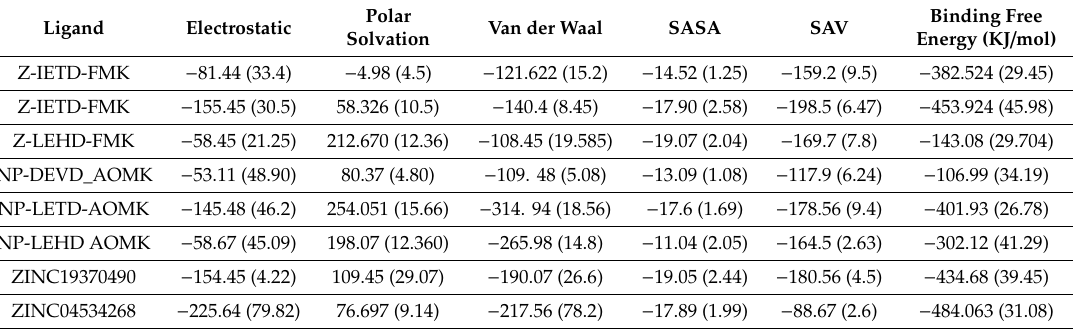
Table 5. MM-PBSA values (binding free energies) of di ff erent ligands with caspase 8. Each value represents the average value calculated from the last 100 snapshots. SASA, solvent accessible surface area; SAV, solvent accessible volume. The standard deviations are given in parenthesis.